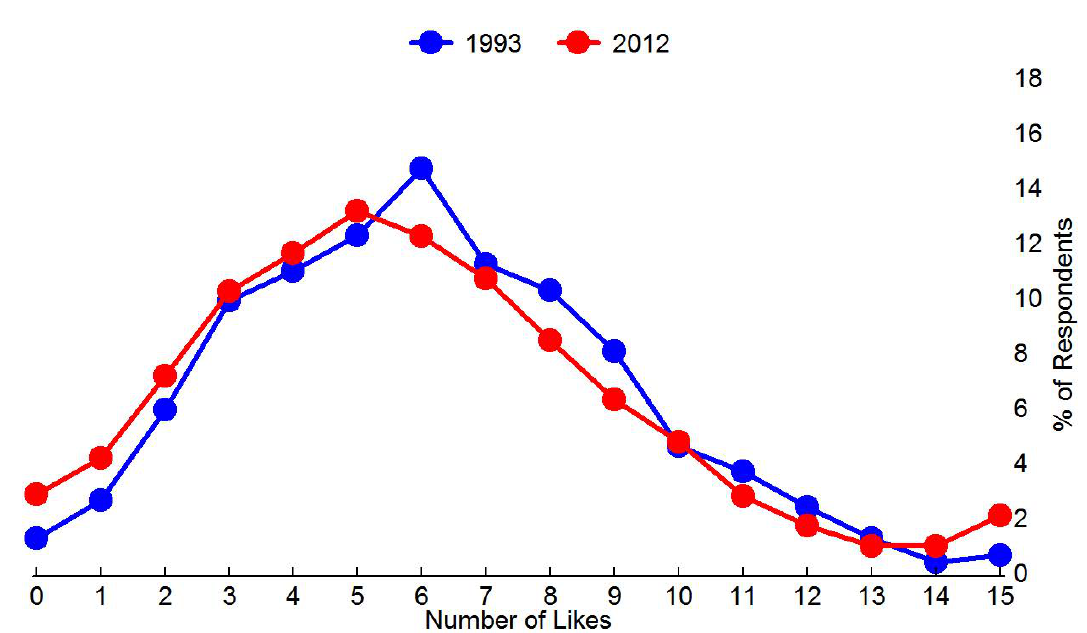
Figure 2: Univariate distribution of counts of the number of likes for GSS 1993 (blue) and SSI 2012